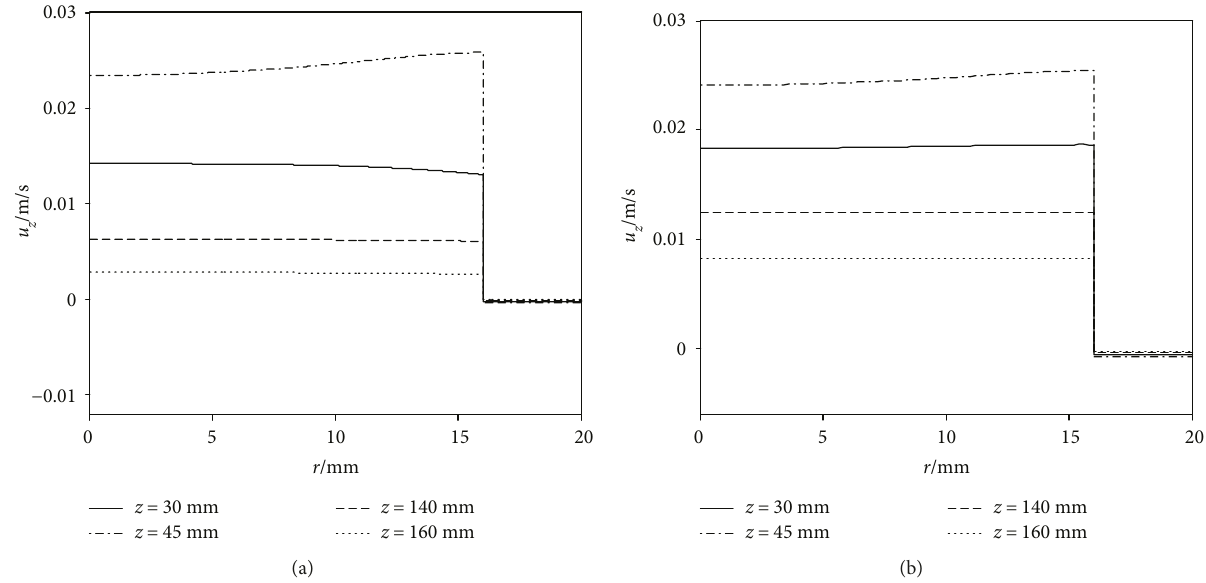
Figure 8: Distribution of axial velocity along the radial direction for di ff erent cases. (a) Distribution for linear boundary condition. (b) Distribution for uniform but asymmetric boundary